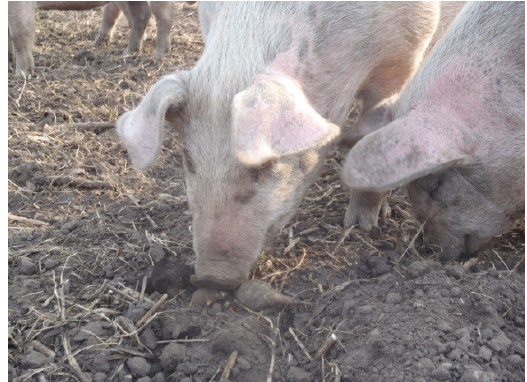
Figure 4. Growing-finishing pigs foraging on lucerne.